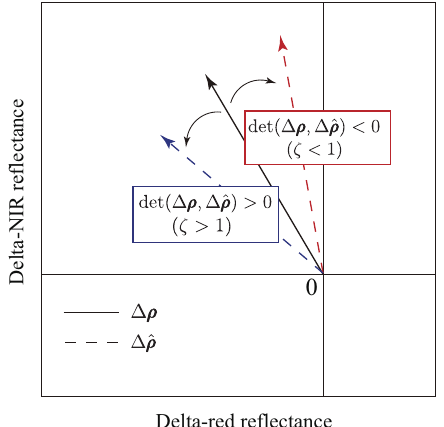
Figure 6. A geometrical interpretation of the variable ζ , the endmember spectra in the model, ∆ˆ ρρρ (colored dashed arrows), and the target field, ∆ ρρρ (a solid arrow). If ζ > 1 , the determinant, det(∆ ρρρ, ∆ˆ ρρρ ) , becomes positive, indicating that the vector over the endmember spectra to be estimated, ∆ˆ ρρρ , should be described in regions of the left-hand side of the vector corresponding to the difference between the true vectors, ∆ ρρρ (a solid vector), indicated in blue. That is, ∆ˆ ρρρ may be expressed as a vector rotated counterclockwise relative to ∆ ρρρ . Similarly, if 0 ≤ ζ < 1 , the determinant is less than unity and ∆ˆ ρρρ may be expressed as a vector rotated clockwise relative to ∆ ρρρ